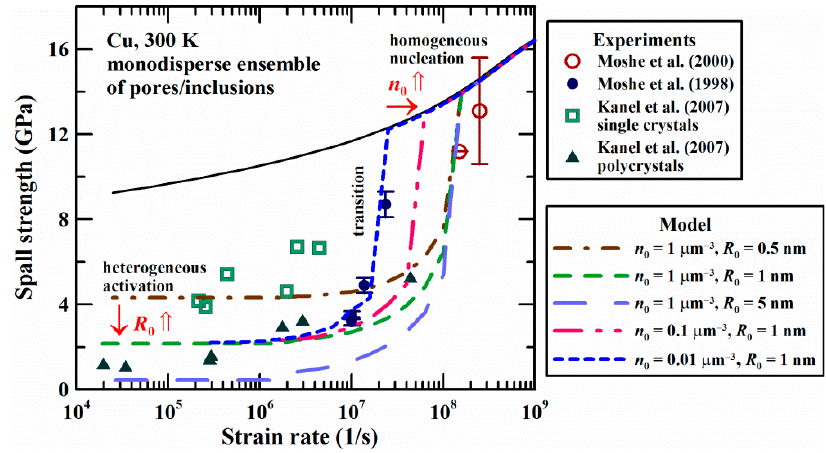
Figure 7. Influence of a monodisperse ensemble of pores or non-wettable inclusions on the strain rate dependence of the spall strength of copper at room temperature: Model results in comparison with the experimental data of Moshe et al. (1998) [15], Moshe et al. (2000) [16], and Kanel et al. (2007) [18]. Solid black curve shows the case of uniform perfect single crystal, in which the homogeneous nucleation of voids triggers the fracture.